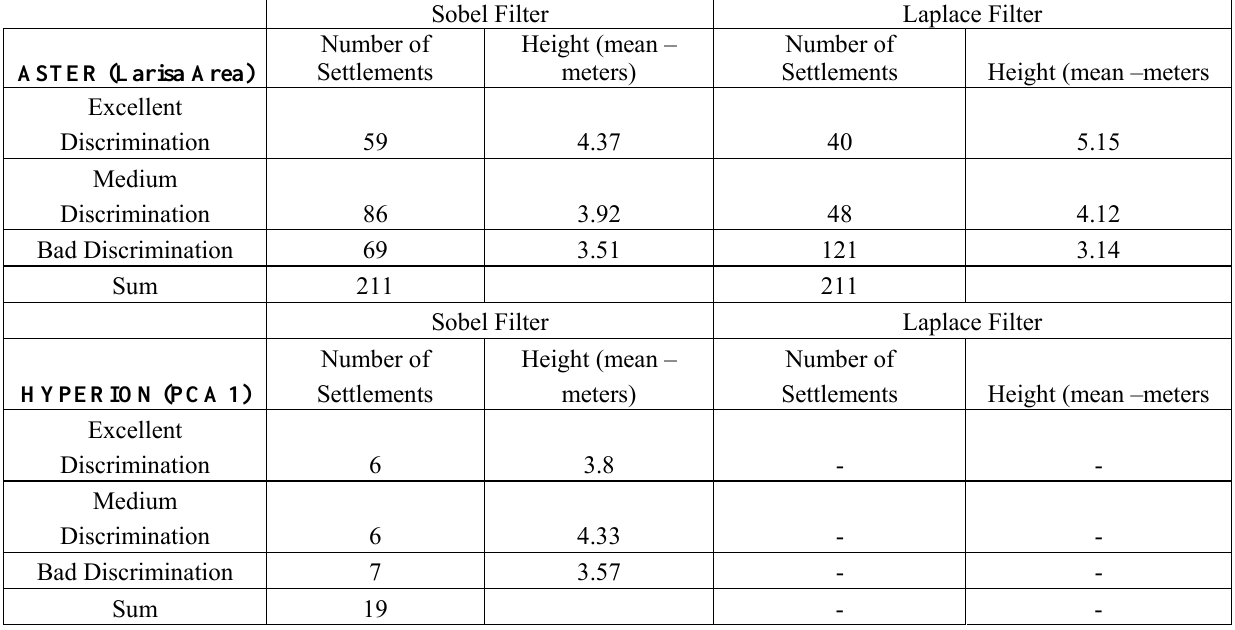
Table 4 . Statistical analysis of the number of settlements that were enhanced after the application of different filters to various images. The grade of discrimination depended on the visual recognition and detection of the